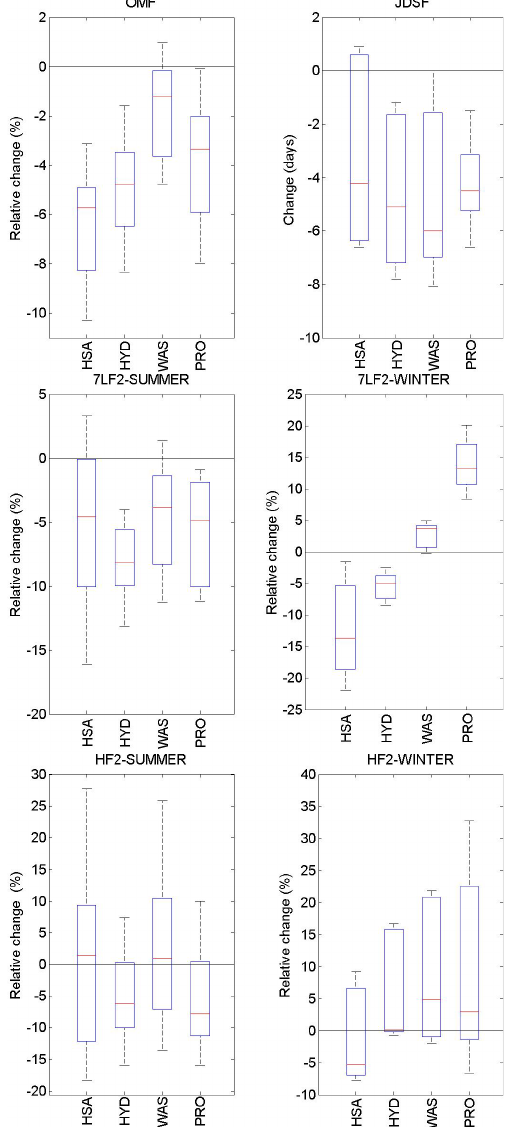
Fig. 7. Changes of hydrological indicators from reference to future period at au Saumon ( Haut St-Franc¸ois , Qu´ebec) of overall mean flow (OMF), the Julian day of spring-flood half volume (JDSF), the 2-yr return period 7-day low flow (7LF2) in summer and winter, and the 2-yr return period high flow (HF2) in summer and winter. For each hydrological indicator, the relative change (as calculated with Eq. 2) is presented. On each box, the central mark is the median, the edges of the box are the 25th and 75th percentiles, and the whiskers extend to the most extreme value.